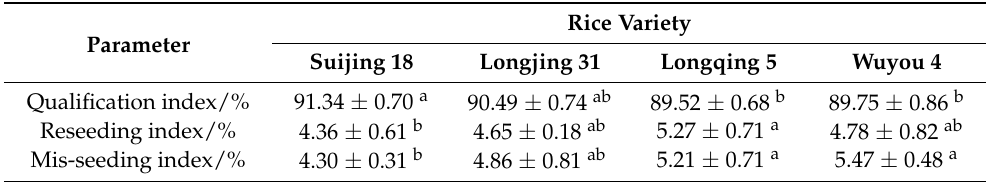
Table 6. Mean values (± standard error) of measuring results of parameters at different rice varieties.